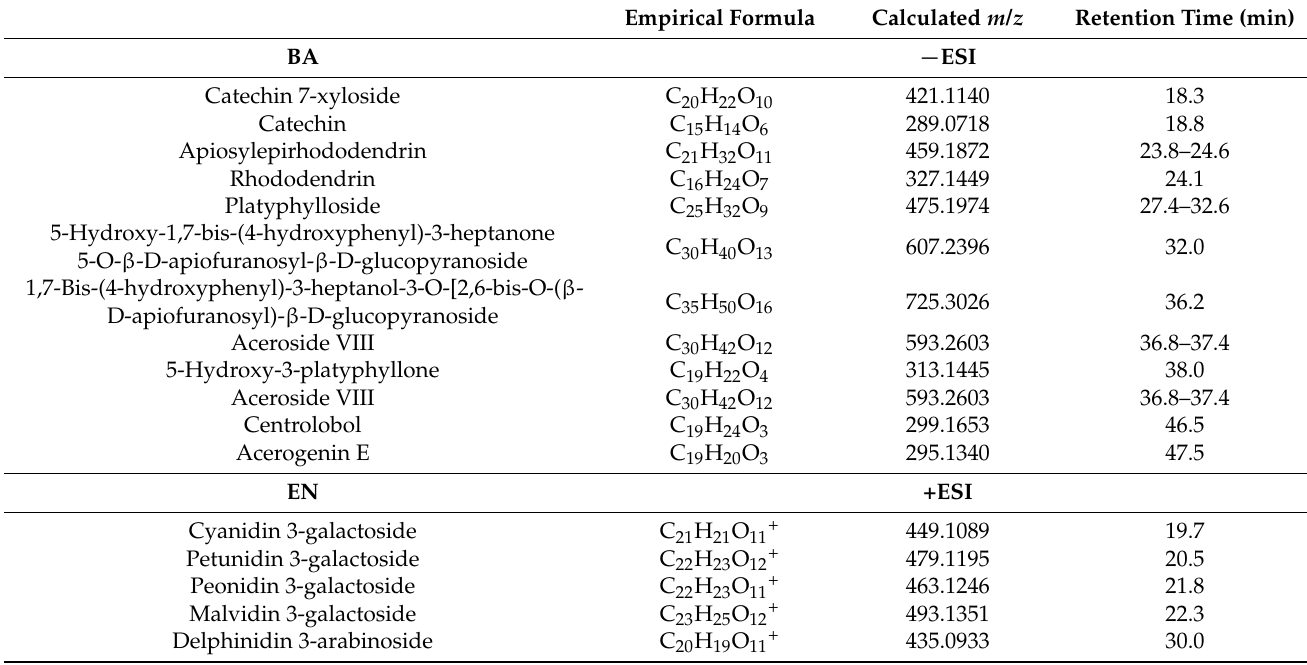
Table 3. List of compounds tentatively identified in BA and EN. UHPLC/ESI-Q-ToF in negative mode was used for BA and positive mode for